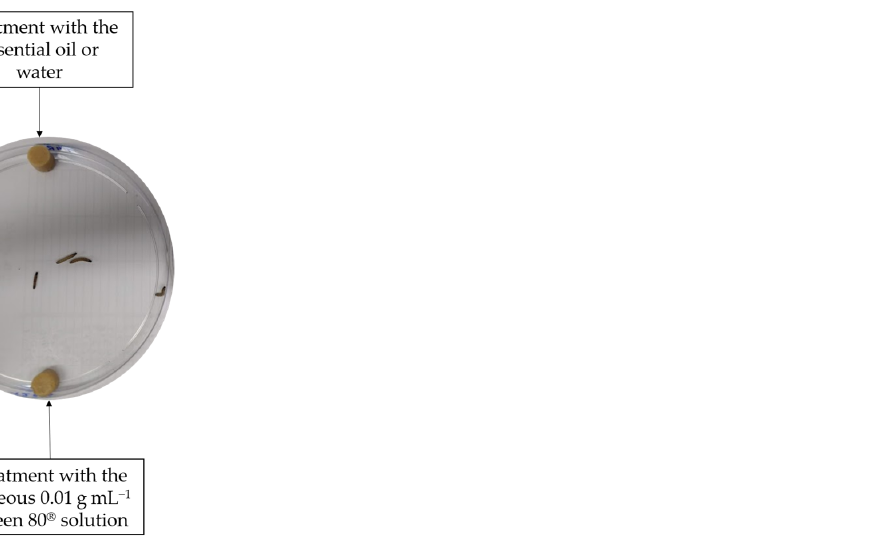
Figure 1. Experimental arena of food preference test of the Spodoptera frugiperda by essential